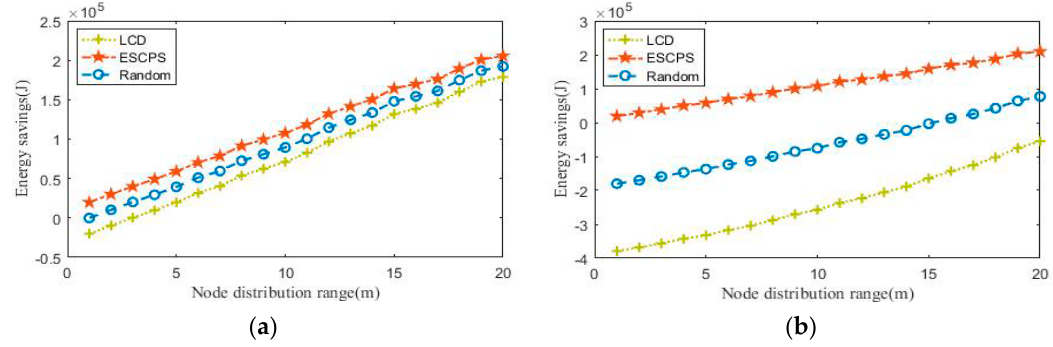
Figure 5. ( a ) The effect of node distribution on energy savings ( P c = 0.1); ( b ) the effect of node distribution on energy savings ( P c = 1).